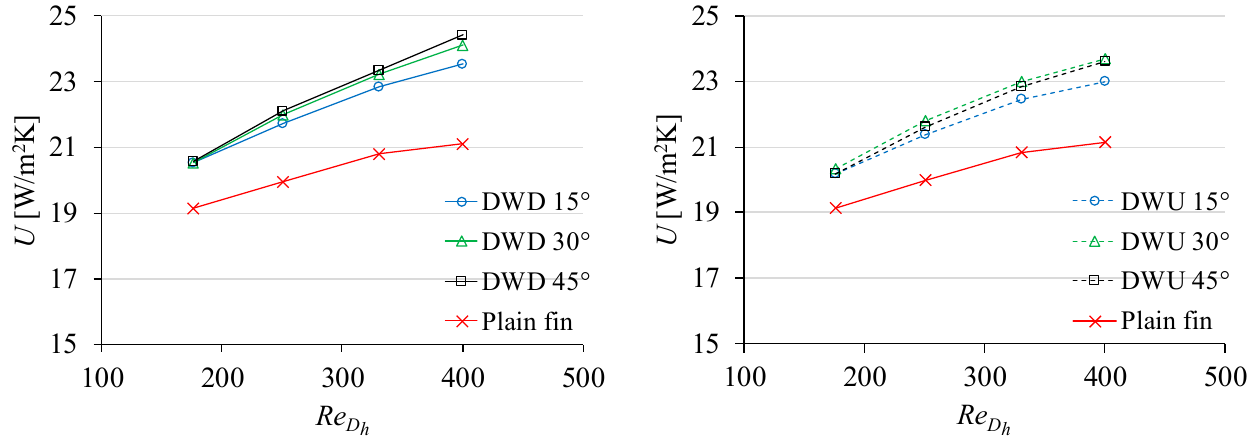
Figure 19. The effect of attack angle on the overall heat transfer coefficient U for air-to-water FTHEX with delta-winglet downstream (DWD, solid lines) and delta-winglet upstream (DWU, dashed lines) configurations. Test conditions: T air,in = 22 °C, T water,in = 40 °C , w water,in = 0.76 m/s.